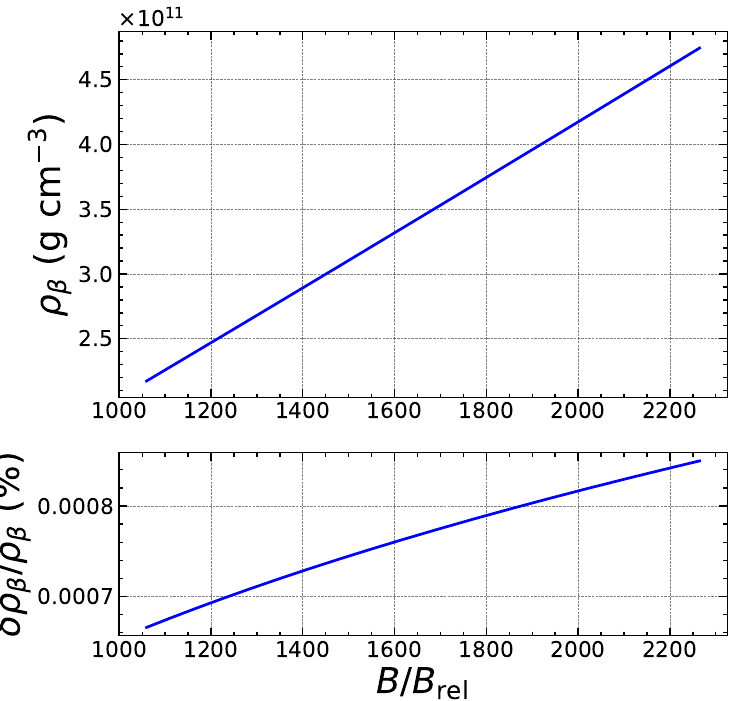
Figure 10. Same as Figure 9 in the strongly quantizing regime.